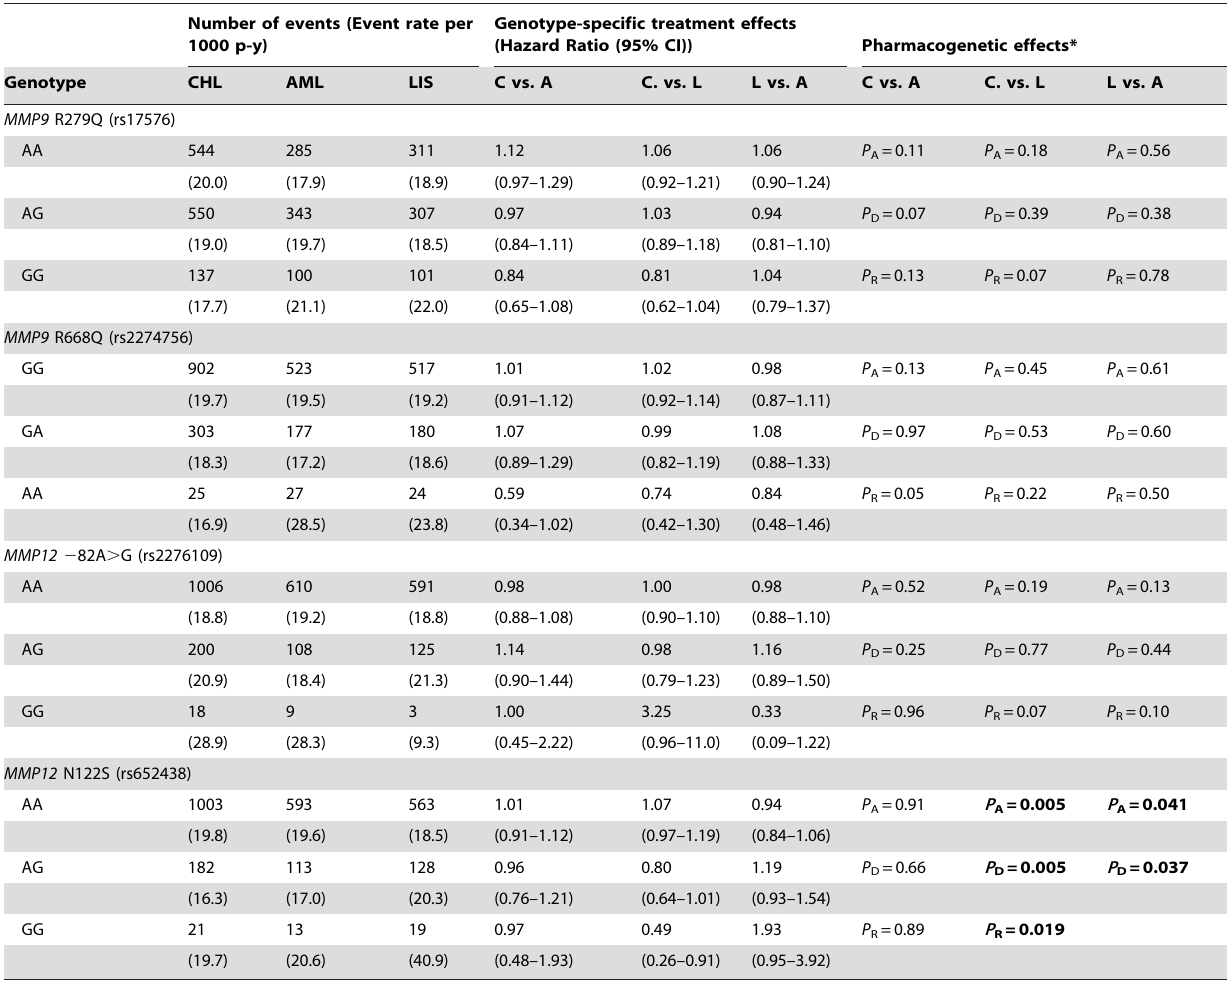
Table 3. Pharmacogenetic effects of MMP genetic variants on